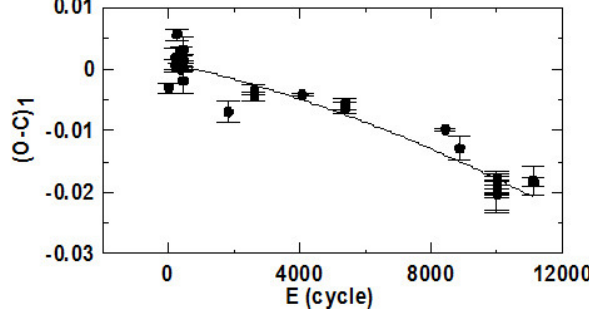
Fig. 7 O-C diagram of IK Boo. Error bars due to minima times determination.